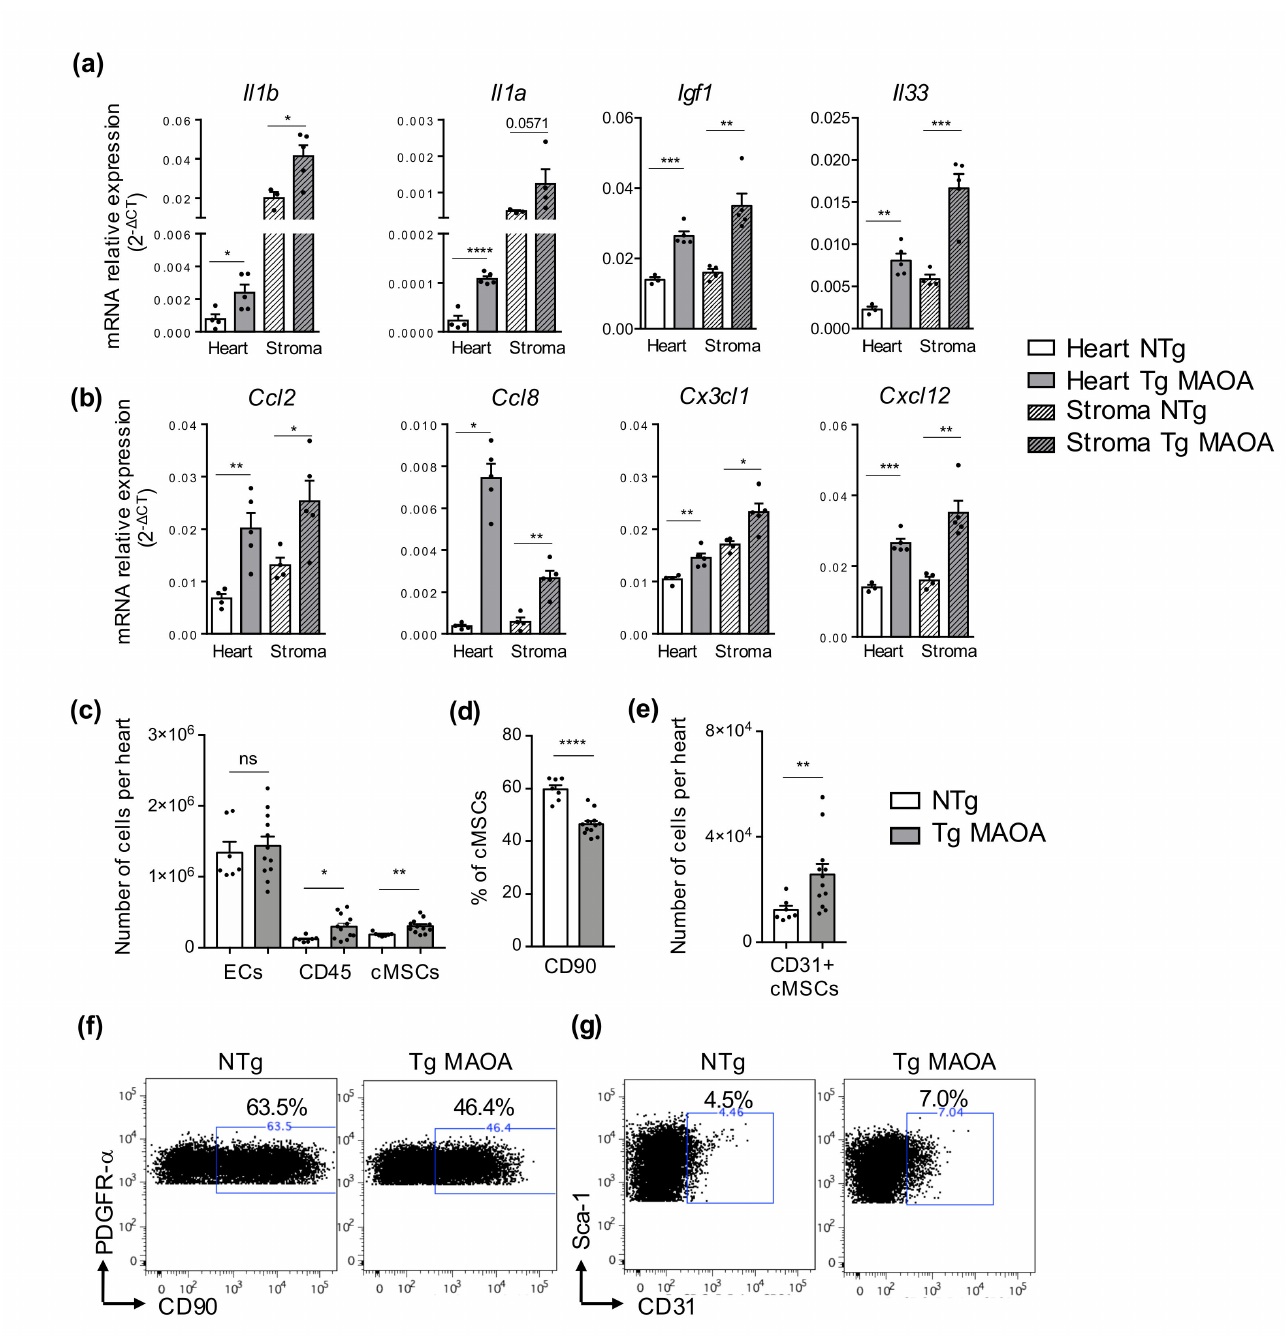
Figure 2. Premature senescence of cardiac stromal cells is associated to expression of SASP factors. ( a , b ) mRNA expression (2e ( − ∆ CT) ) relative to gapdh of cytokines and growth factors ( a ) and chemokines (b) of heart and stromal cells from Tg MAOA ( n = 5) and NTg ( n = 4). ( c ) Numbers of endothelial cells (ECs), immune cells (CD45) and cardiac mesenchymal stromal cells (cMSCs) per heart ventricles of NTg ( n = 7) and Tg MAOA ( n = 12) mice analyzed by flow cytometry. ( d ) Percentage of CD90 positive cMSCs of NTg ( n = 7) and Tg MAOA ( n = 12) mice determined by flow cytometry. ( e ) Numbers of CD31 + cMSCs per heart ventricles of NTg ( n = 7) and Tg MAOA ( n = 12) mice by flow cytometry. ( f , g ) Representative dot-plots of PDGFR- α and CD90 ( f ) and of Sca-1 and CD31 ( g ) expression by cMSCs. Percentages of cells positive for CD90 ( f ) or for CD31 ( g ) out of total cMSCs from NTg and Tg MAOA mice are shown. Data are expressed as means ± SEM. * p < 0.05, ** p < 0.01, *** p < 0.001, **** p < 0.0001 vs. NTg